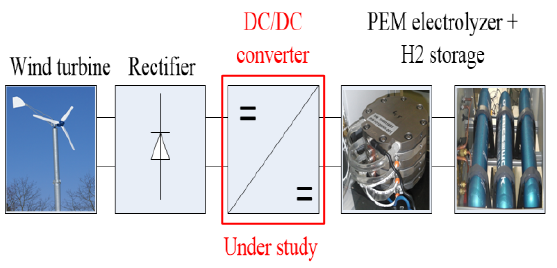
Fig. 2. Hydrogen generation pathways from wind turbines.